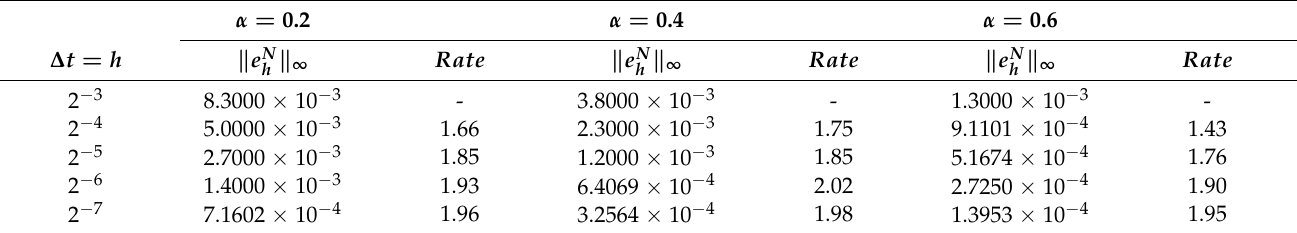
Table 3. Error behaviors and rate with α = 0.2,0.4,0.6 at time T = 1 for Example 2.